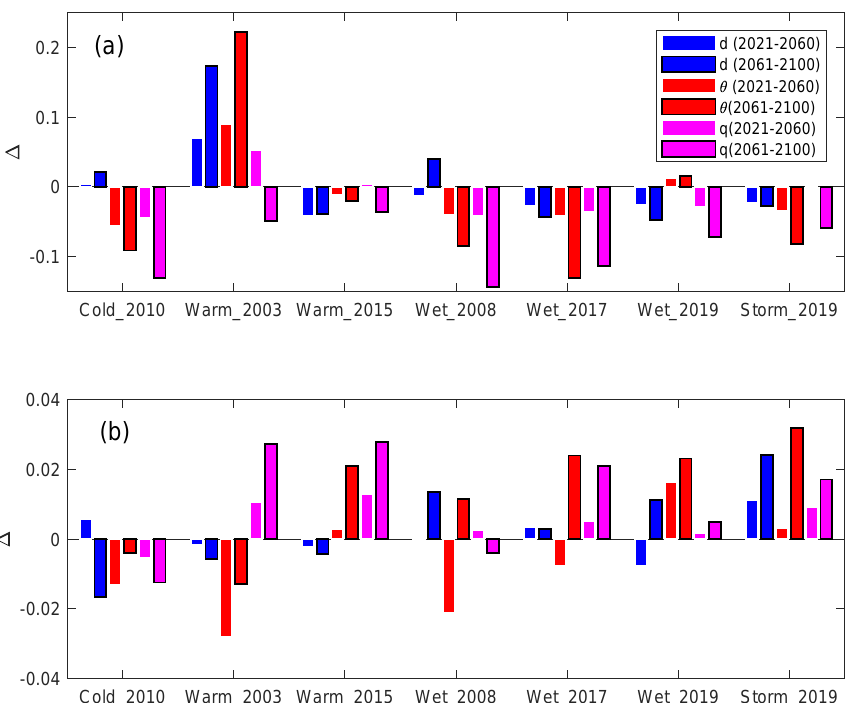
Figure 10. Upper panel ( a ): d , θ and analogue quality ( q ) changes in the “raw” simulations ( ∆ values). Lower panel ( b ): d , θ and analogue quality ( q ) changes in the "detrended" simulations. Each of the seven selected events is represented by six bars. The blue bars are for changes of local dimension d between a reference period 1979–2019 and two SSP585 scenario sub-periods (2021–2060 and 2061–2100). The red bars are for changes in persistence theta . The purple bars are for changes in the distances of Z500